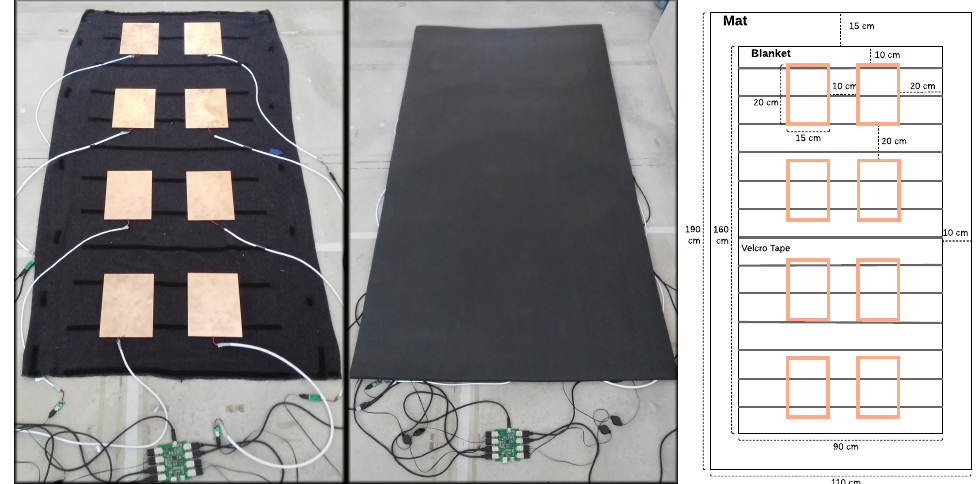
Figure 4. Prototype of our proposed sensing mat for sport exercise recognition by using eight capacitive proximity sensors. The symmetrical setup is used to allow the option for easy data augmentation process.